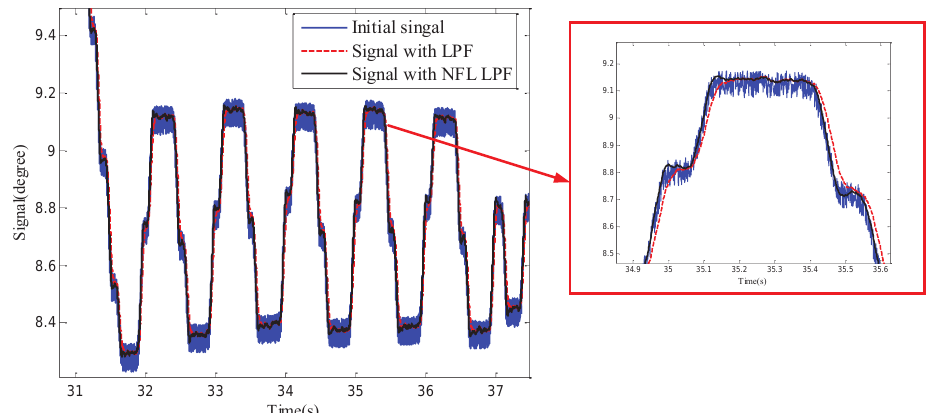
Figure 8. Comparison of initial and filtered signals.